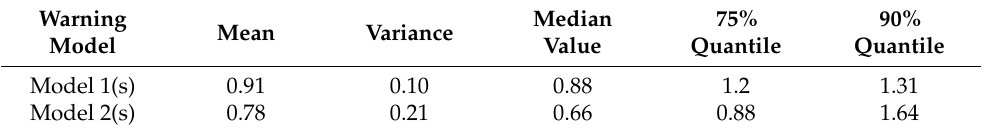
Table 4. Statistics of warning response